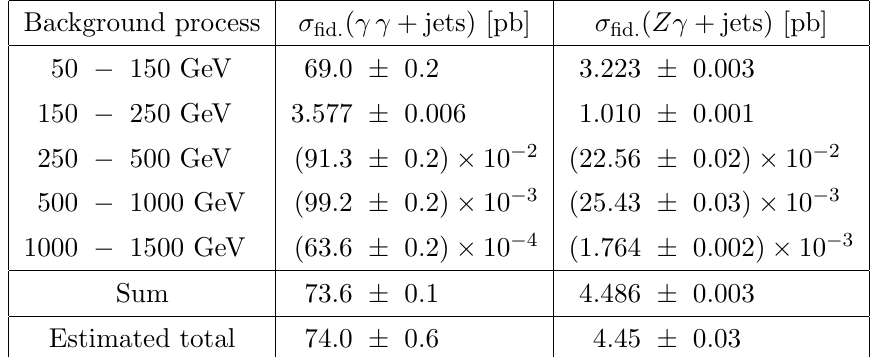
slice in the (cid:13)(cid:13)